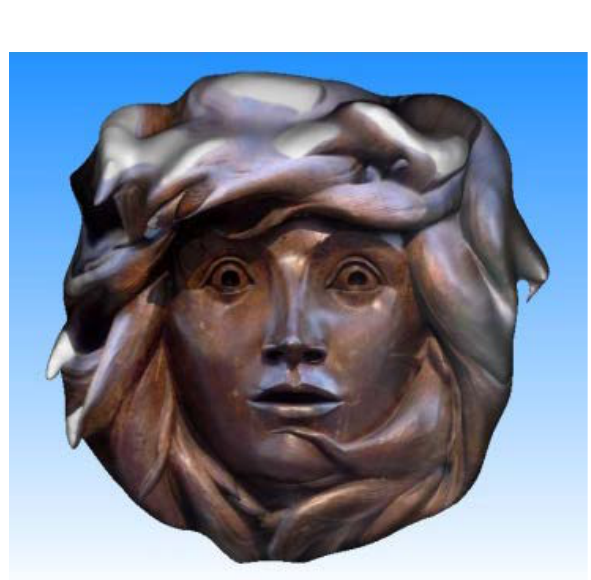
Figure 11. Smoothing.